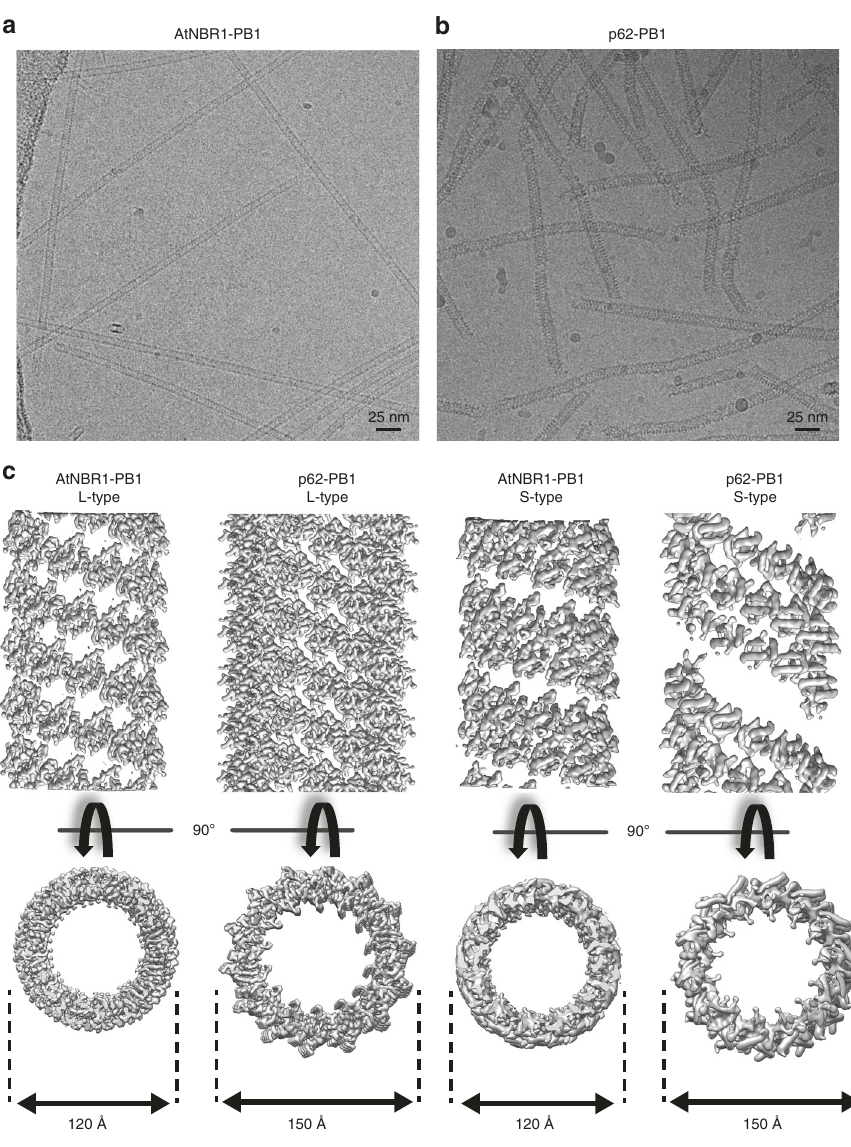
Fig. 2 Cryo-EM structures of AtNBR 11 – 94 and p62 1 – 122 . a Electron cryo-micrograph of AtNBR1 – PB1 1 – 94 and ( b ) p62-PB1 1 – 122 assemblies. c Side and top views for determined cryo-EM structures of L-type AtNBR1 – PB1 (far left), p62-PB1 (left), and S-type assembly of AtNbr – PB1 (right), p62-PB1 (far